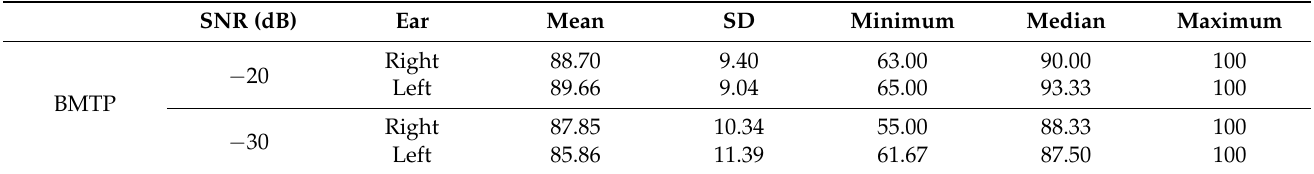
Table 1. Descriptive statistics for performance in percentage of correct responses (BMTP) and target sound detection threshold (BMTT) in the NA group for the backward masking test (BMT), according to the signal-to-noise ratio (SNR) and ear assessed.